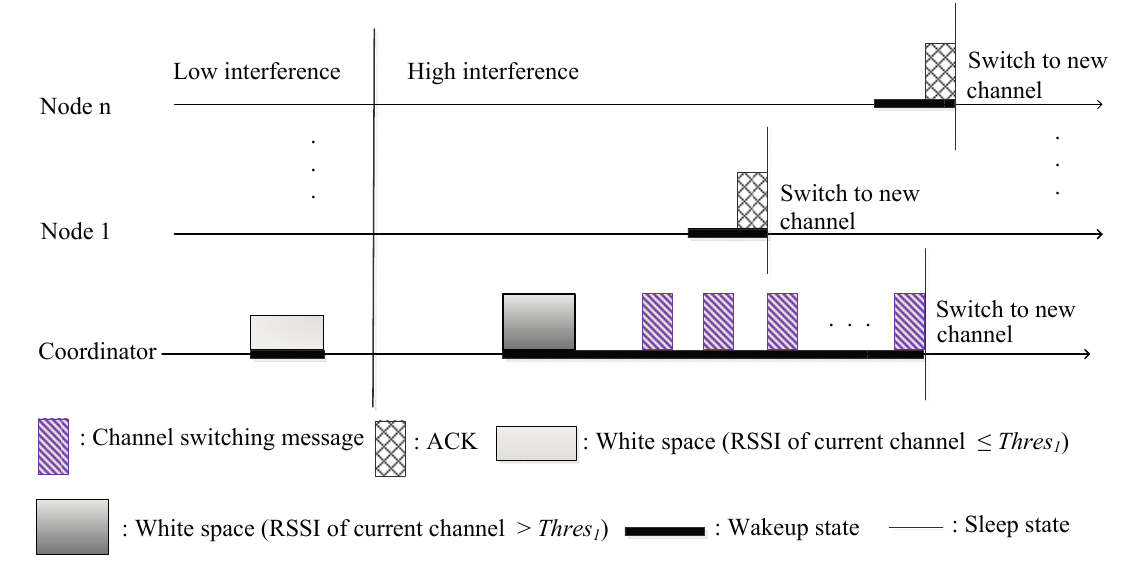
Figure 5. Channel switching in